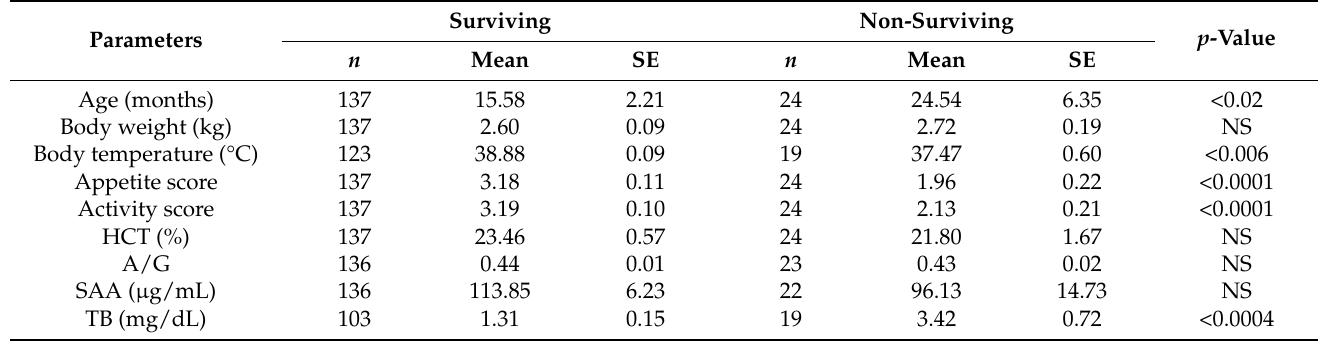
Table 3. Statistical comparison of signalment and clinical parameters between surviving and non- surviving cats with mixed